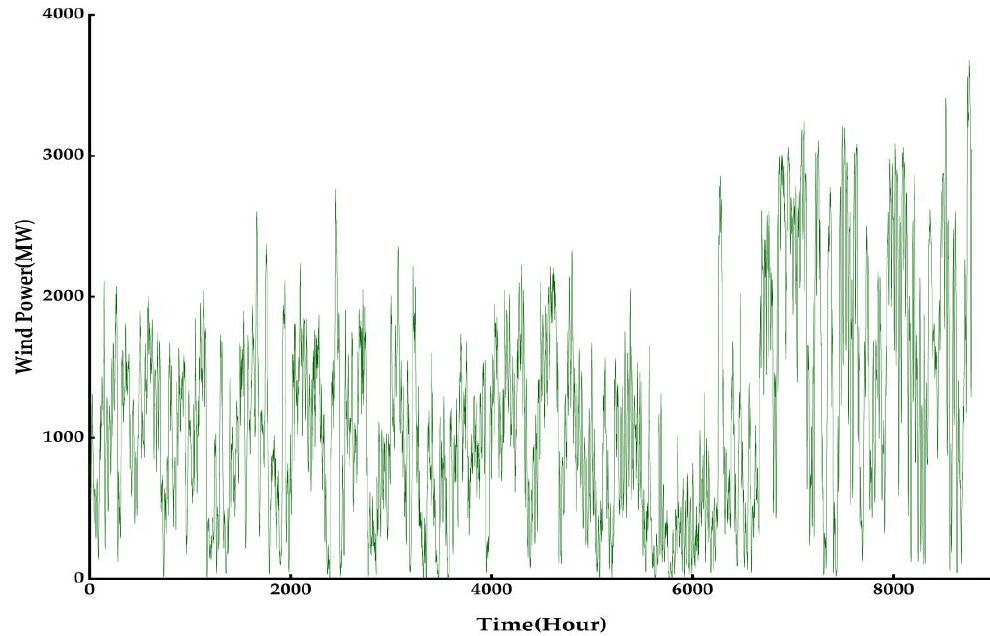
Figure 5. Hourly distribution data of onshore wind power in Guangxi in 2020.